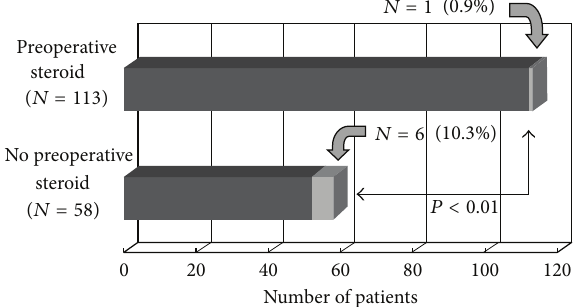
Figure 1: Postoperative respiratory failure and myasthenic crisis after thymectomy: postoperative respiratory failure and myasthenic crisis occurred only in a patient (0.9%) in preoperative steroid treat- ment group but did occur in 6 patients (10.3%) in no preoperative steroid treatment group during intraoperative period ( 𝑃 < 0.01 , 𝜒 2 - test).